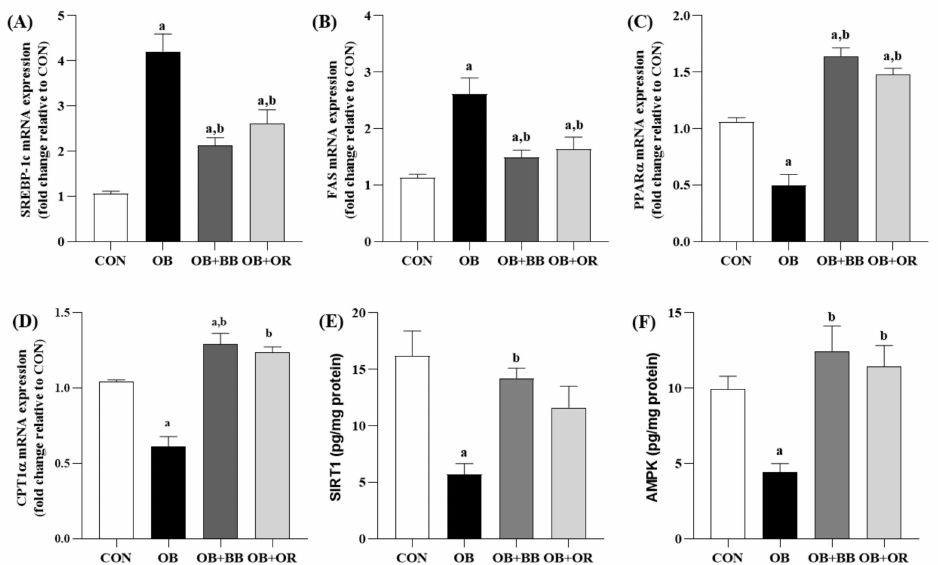
Figure 5. Effect of bee bread on hepatic lipid metabolism-related genes, and SIRT1 and AMPK levels. ( A – D ) The mRNA expression levels of SREBP-1c, FAS, CPT1 α and SIRT1 were determined by RT-qPCR assays ( n = 6/group). ( E , F ) The levels of SIRT1 and AMPK were detected using ELISA ( n = 8/group). Values are presented as mean ± SEM. CON, control; OB, obese; OB + BB, obese + bee bread 0.5 g/kg body weight/day; OB + OR, obese + orlistat 10 mg/kg body weight/day; SREBP-1c, sterol regulatory element-binding protein-1c; FAS, fatty acid synthase; PPAR α , peroxisome proliferator activated receptor α ; CPT1 α , carnitine palmitoyl transferase 1 α ; SIRT1, sirtuin 1; AMPK, AMP-activated protein kinase. One-way ANOVA, followed by Tukey post-hoc test. a p < 0.05 vs. CON group, b p < 0.05 vs. OB